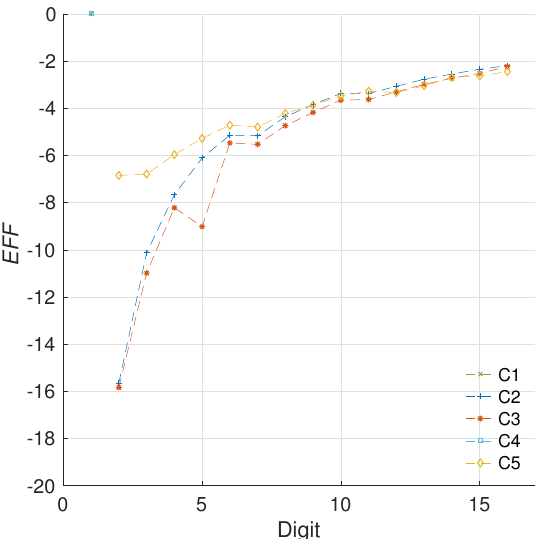
Figure 8. Evaluation of the efficiency metric for the different kP configurations.